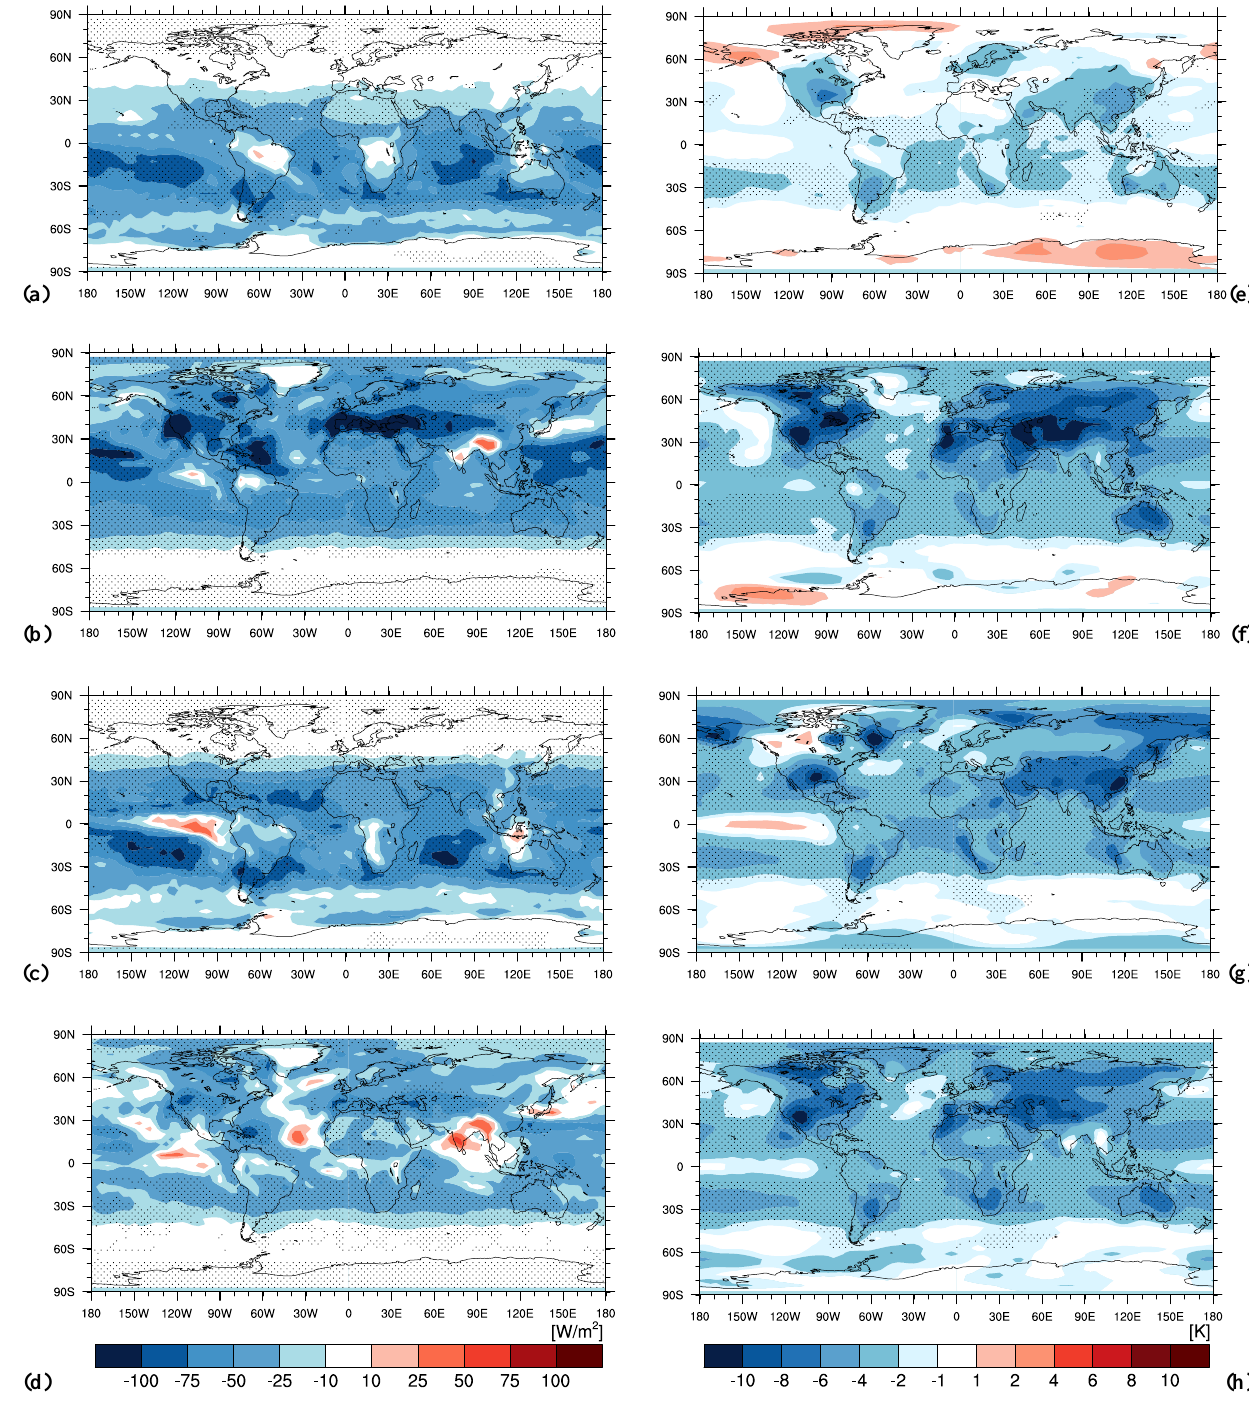
Fig. 4. Maps of ensemble and monthly mean anomalies of (a–d) short-wave radiation at the Earth’s surface ([W m − 2 ], left column) and (e–h) surface air temperature SAT ([K], right column). For (a, e) month 12 (December year 1), (b, f) month 18 (June year 2), (c, g) month 24 (December year 2), and (d, h) month 30 of the experiment (June year 3). Stippled areas indicate significance of anomalies based on the 2- σ